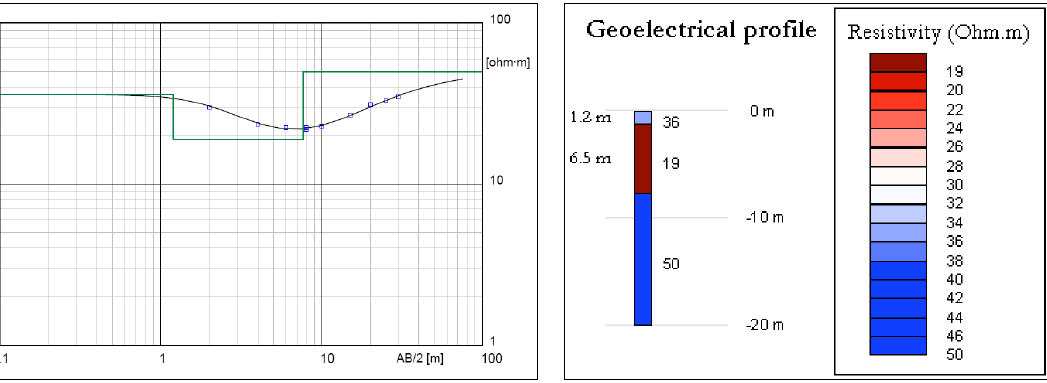
Fig. 6. (a) Field resistivity plot with 3-layer interpretation (given by the shape of the obtained curve). (b) Geo-electrical profile. Geophysical investigation and